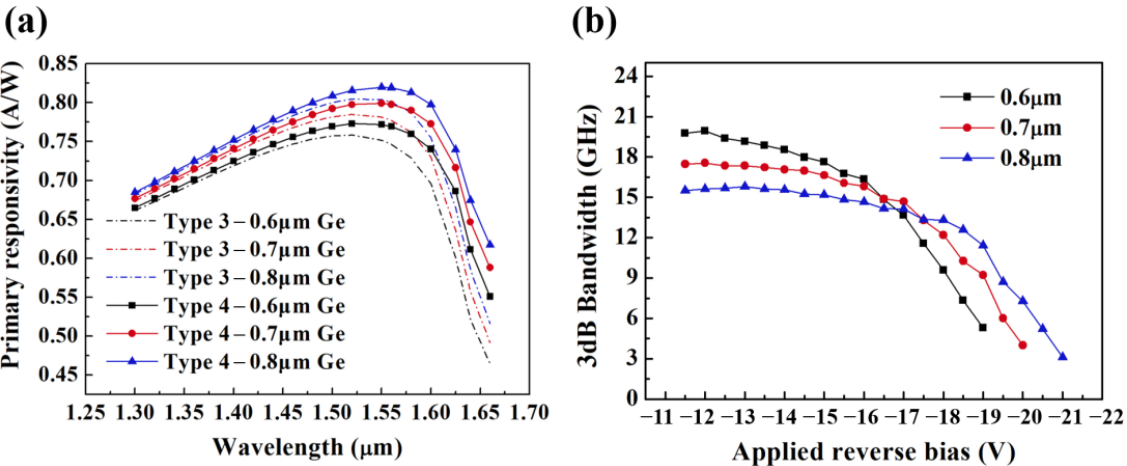
Figure 7. ( a ) The primary responsivity and ( b ) 3-dB bandwidth of APDs based on type 3 and type 4 with different Ge absorption layer thicknesses (0.6, 0.7 μm , 0.8 μm ).